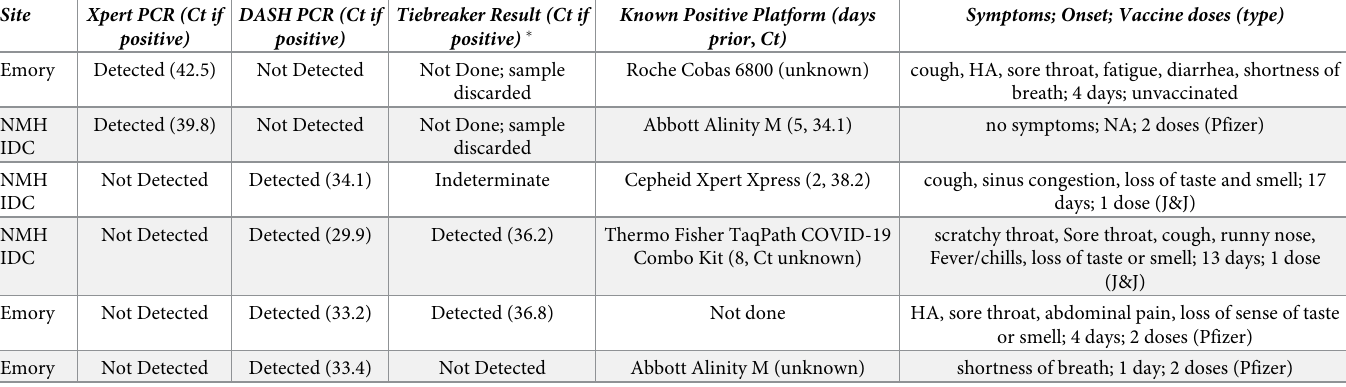
Table 4. Summary of discordant results between Diagnostic Analyzer for Selective Hybridization (DASH) and Cepheid Xpert Xpress (Xpert) PCR